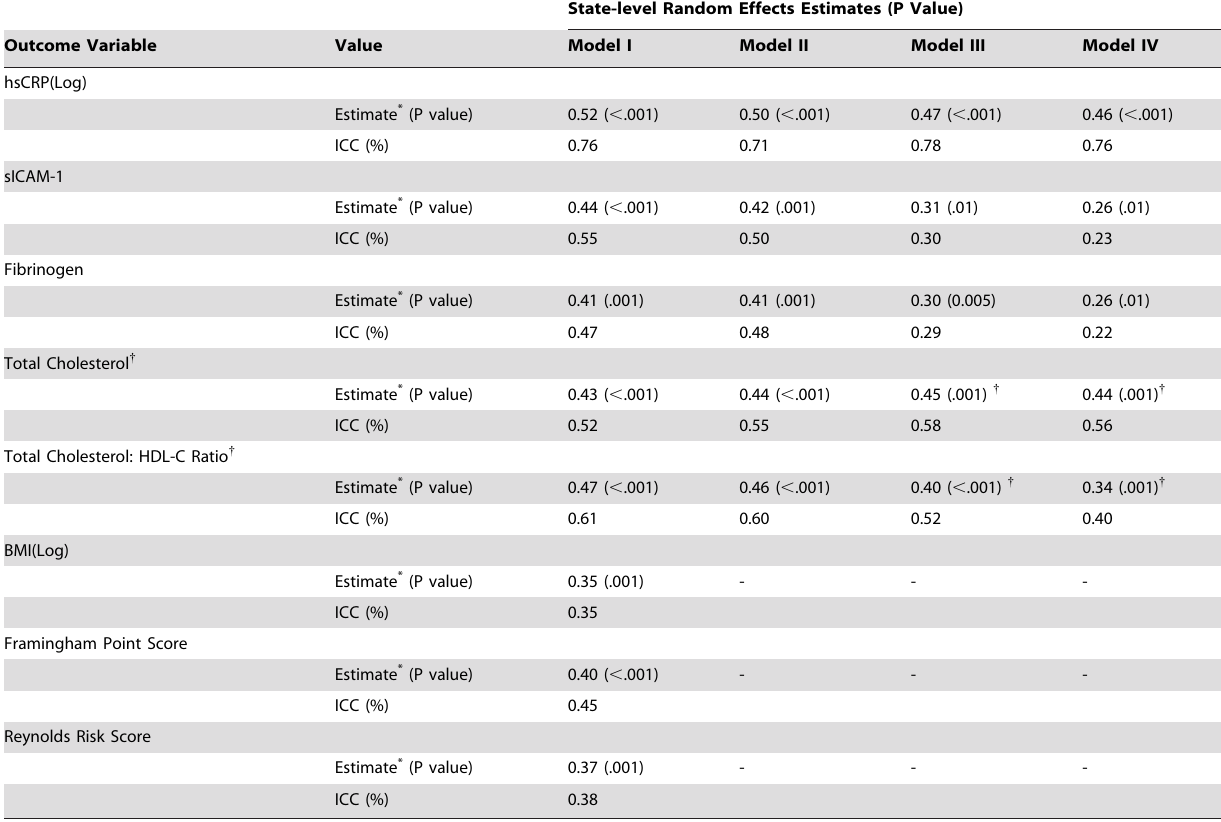
Table 2. State-Level Variation in Cardiovascular Inflammatory Biomarkers, Risk Factors, and Clinical Risk